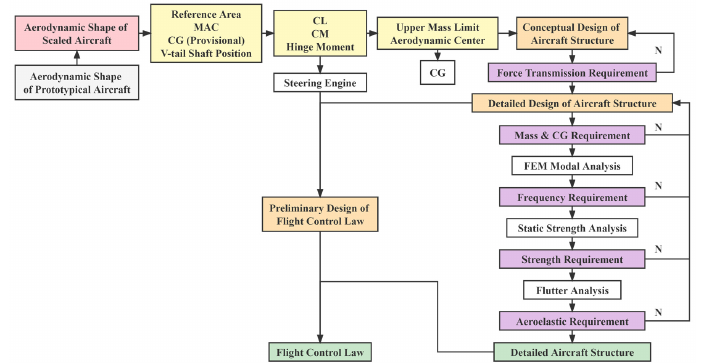
Figure 1. The design process of the aircraft model.